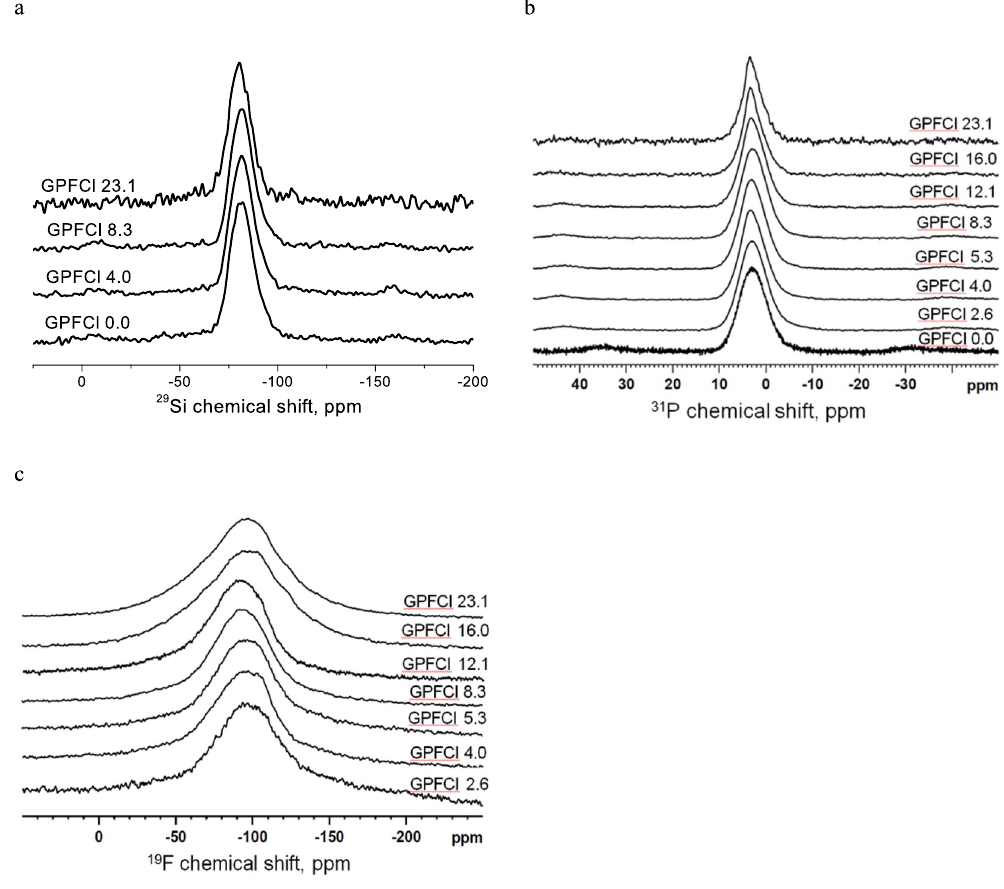
Figure 6. ( a ) The 29 Si MAS-NMR spectra ( b ) 31 P MAS-NMR spectra and ( c ) 19 F MAS-NMR spectra of the as- quenched mixed CaF 2 and CaCl 2 containing